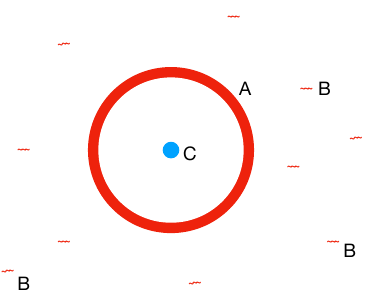
Figure 9 . Region A describes the degrees of freedom near the black hole horizon. Region B describes Hawking radiations. D-branes described by region C are sitting at the origin of R 9 − p , inside the